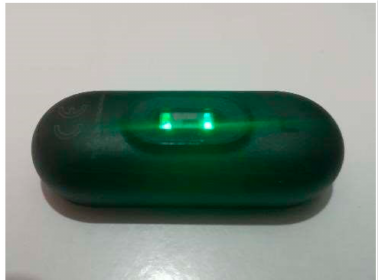
Figure 7. Photoelectric sensor.